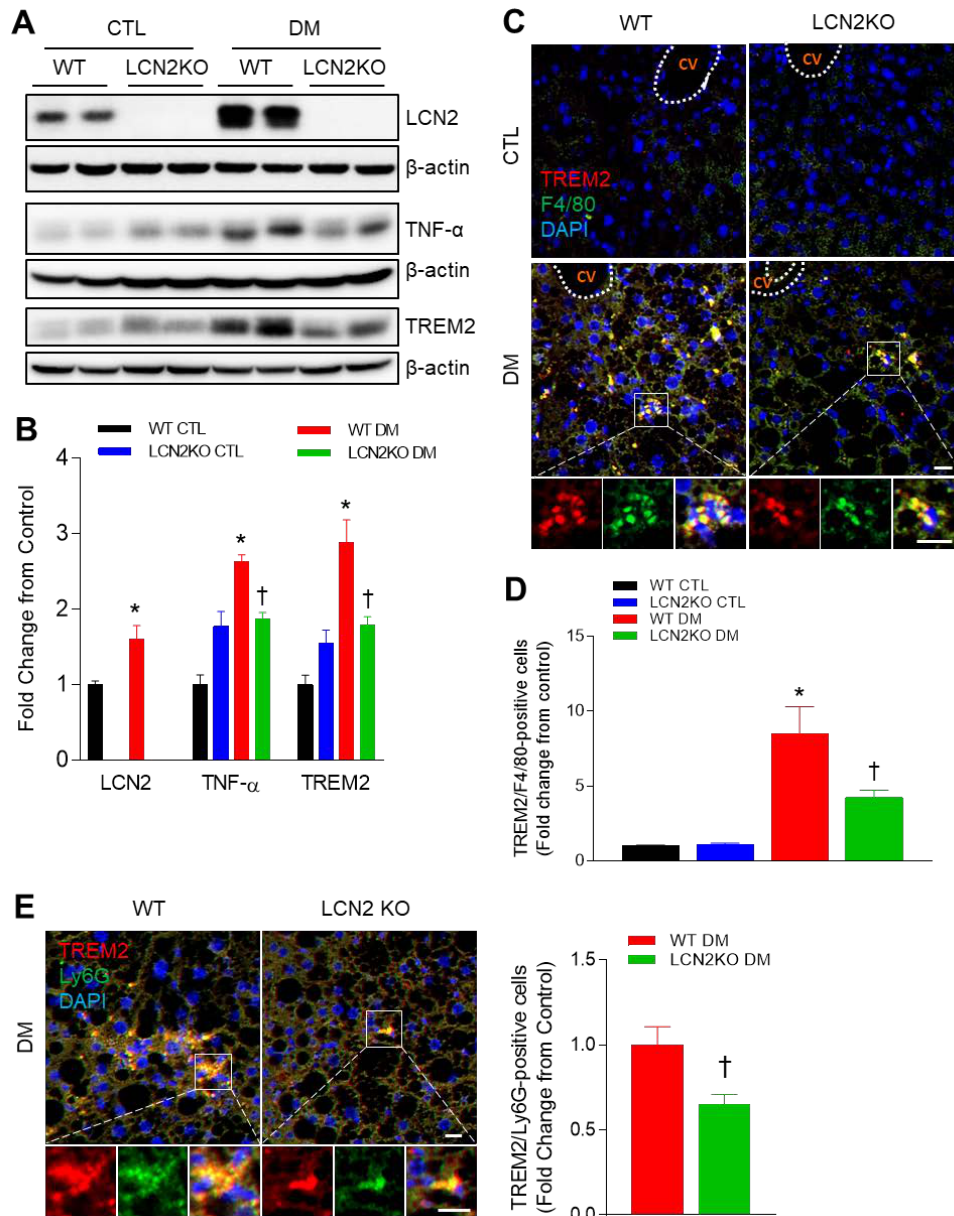
Figure 3. Effects of LCN2 deletion on hepatic TREM2 expression in HFD/STZ-induced diabetic mice: ( A , B ) Western blot analysis and quantitation of LCN2, TNF- α , and TREM2 proteins in liver lysates. β -actin was used as loading control; ( C ) representative immunofluorescence images of TREM2 (red) and F4/80 (green) in liver sections; CV: central vein; ( D ) quantification of co-localized TREM2 and F4/80-immunostained cells in the images; ( E ) representative immunofluorescence images of TREM2 (red) and Ly6G (green) in liver section; quantification of co-localized TREM2 and Ly6G-immunostained cells in the images; scale bar = 10 µm. DAPI (blue) was used to stain nuclei. CTL: control; DM: diabetic mice. Data are presented as the mean ± SEM. The indicated p -values represent a two-way ANOVA, followed by Tukey’s post hoc test. * p < 0.05 vs. WT CTL. † p < 0.05 vs. WT DM.